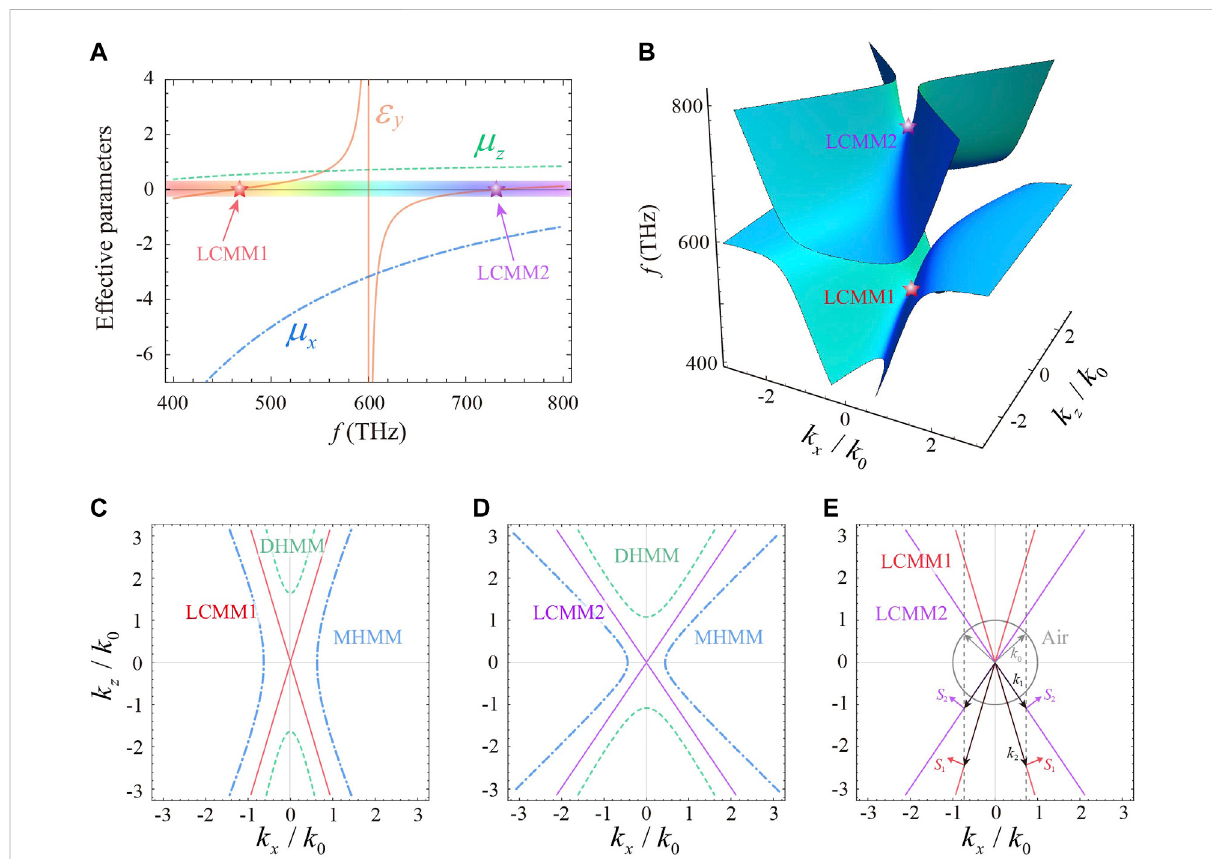
FIGURE 2 MLCMM based on the Drude-Lorenz model. (A) Effective anisotropic electromagnetic parameters of the MLCMM based on the Drude-Lorenz model. μ x , ε y ,and μ z arerepresentedbybluedashdottedline,redsolidline,andgreendashedline,respectively. (B) The3Ddispersionrelationshipsof two kinds of hyperbolic topological transitions. LCMM1 and LCMM2 are marked by red and purple stars, respectively. (C) The cross graphs of the 3D dispersionrelationshipsforthelowfrequencyhyperbolictopologicaltransitionin (B) .IFCsofdielectric-typeHMM(DHMM),LCMM1,andmetal- type HMM (MHMM) at 400 THz, 463 THz, and 550 THz are marked by green dashed line, red solid line and blue dashdotted line, respectively. (D) Similar to (C) , but for the high frequency hyperbolic topological transition. (E) Multi-frequency directional refraction expressed from the linear dispersion when the light incident from air to